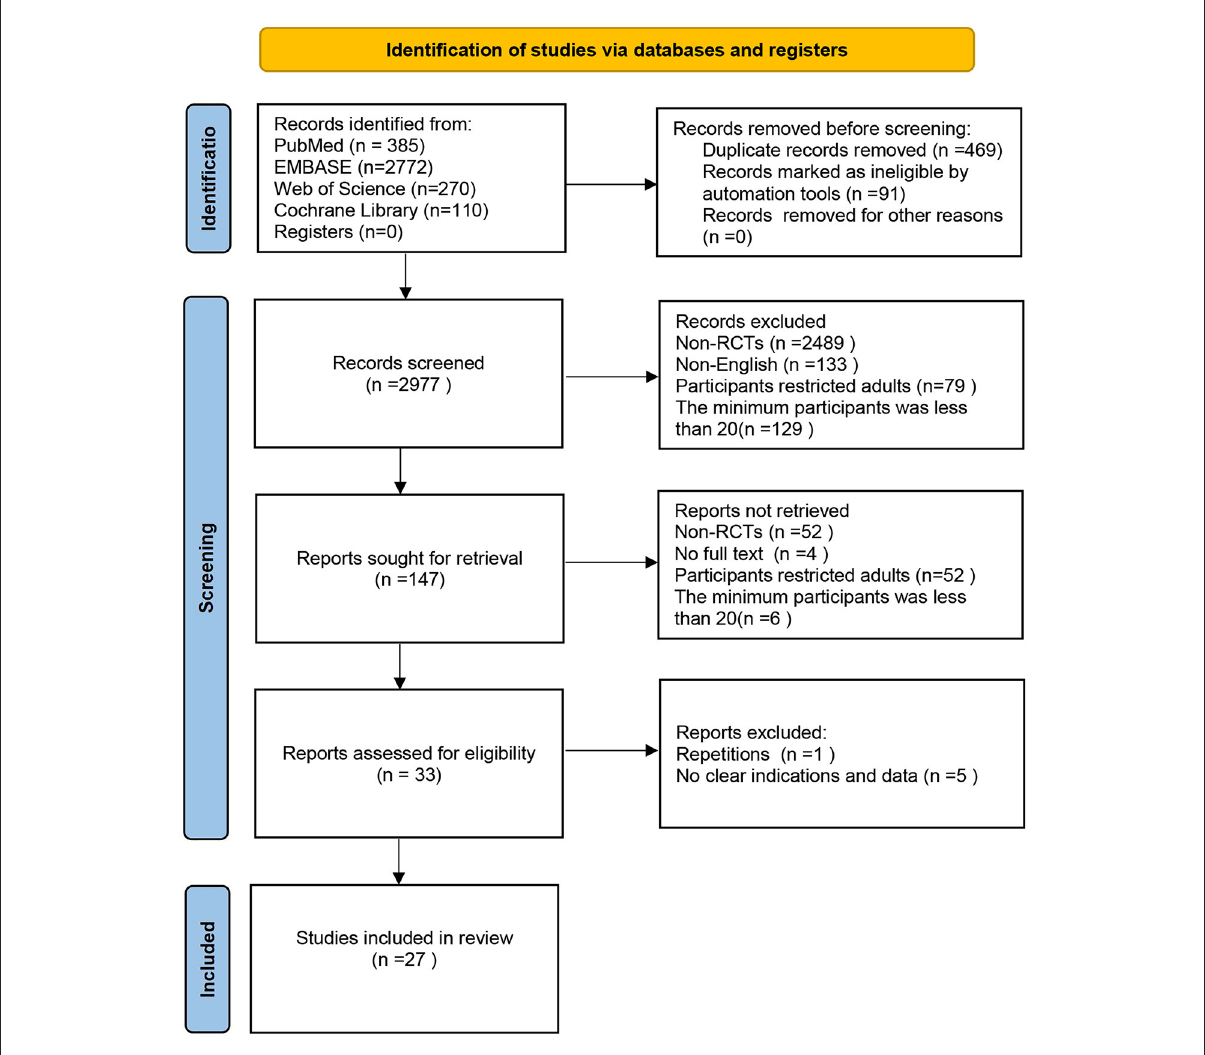
FIGURE1 Flowchart for literature retrieval and the process of